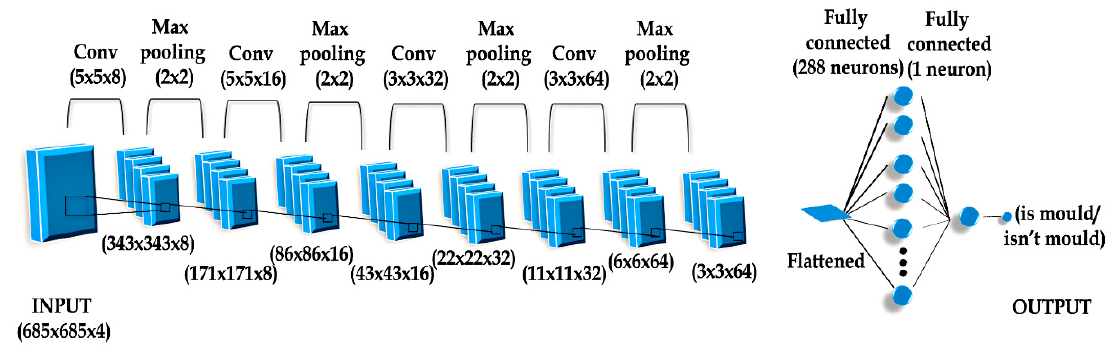
Figure 6. Structure of adequate Convolutional Neural Networks.